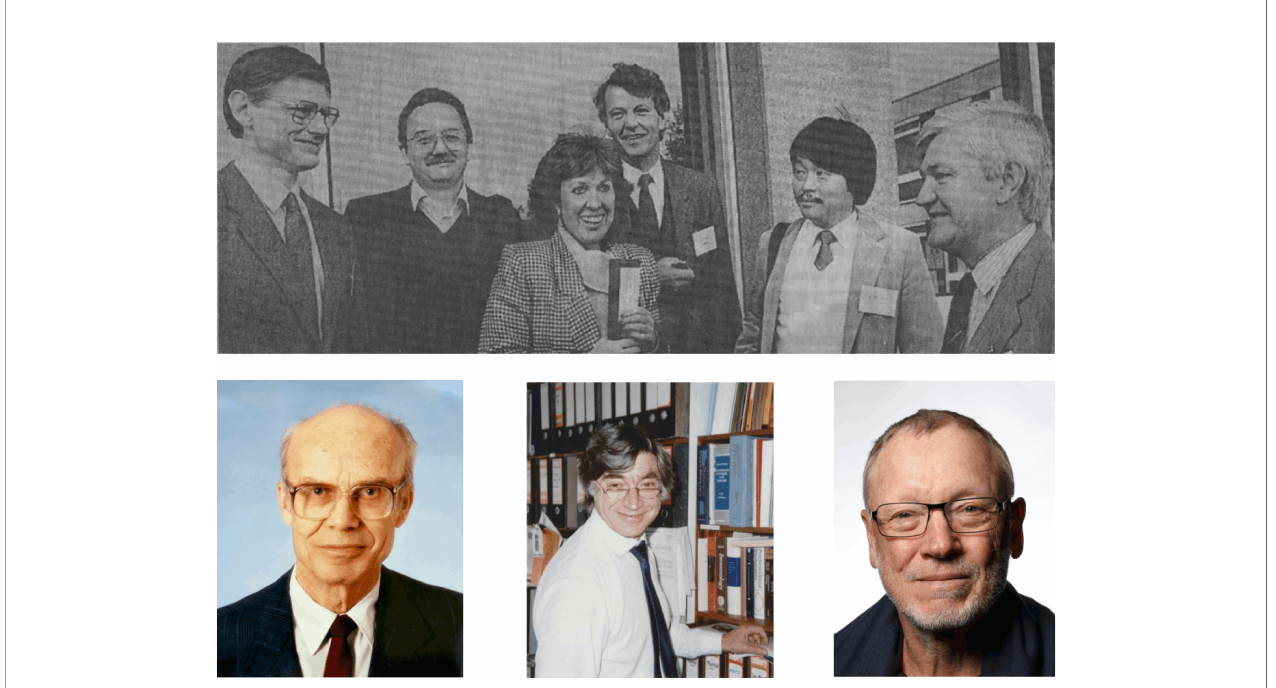
FIGURE 2 | Contributors to some of the early milestones on proglucagon-derived peptides. Top panel (from left): Professor Steve Bloom, Professor J. Michael Conlon, Professor Julia Polak, Professor Flemming Stadil, Professor Kazuhiko Tatemoto and Professor Keith Buchanan pictured at the Annual Meeting of Bayliss & Starling Society, held in Belfast 1987 (reproduced with permission from Belfast Telegraph). Bottom panels (from left): Professor Bo Hellman (1996), Professor Vincent Marks (1989) and Professor Jens Holst (2020). BH by Lennart Nilsson, VM by PRF and JJH by Ricky Molloy. All photographs reproduced with